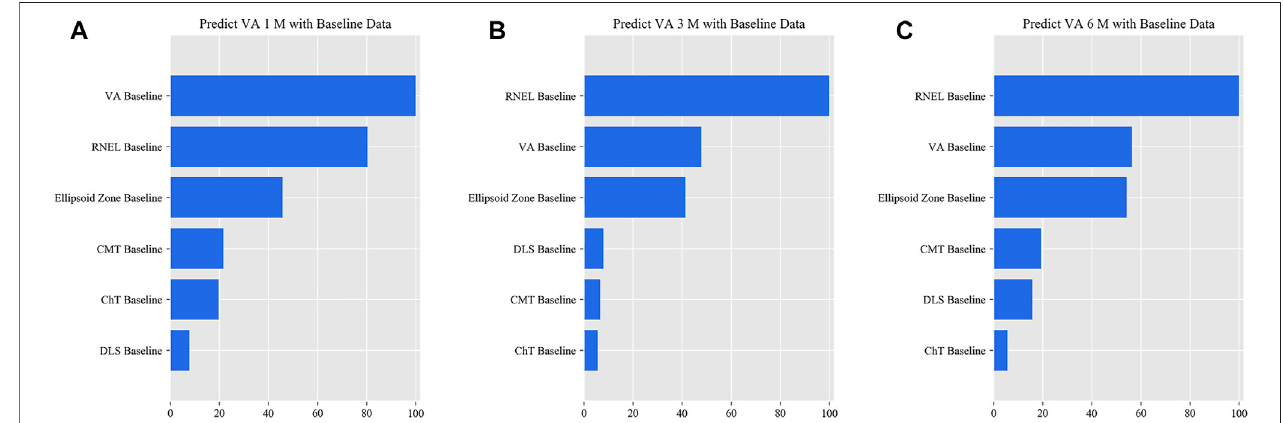
FIGURE6| Relativeimportanceofdifferentfeatures forprediction forsimpli fi edmodel Ⅱ .Theseplotsshowtheweights ofthedifferentfeaturesintheVAprediction task 1, 3, and 6 months after lasertreatmentfor model Ⅱ . Theresults werestrati fi ed accordingto thefollow-upperiod and the points inputinto thealgorithms; this fi gure shows only the relative importance of the baseline data. The red bar indicates the average importance of the feature in the blending algorithm. (A) Feature weights in the 1-month VA prediction. (B) Feature weights in the 3-month VA prediction. (C) Feature weights in the 6-month VA prediction.